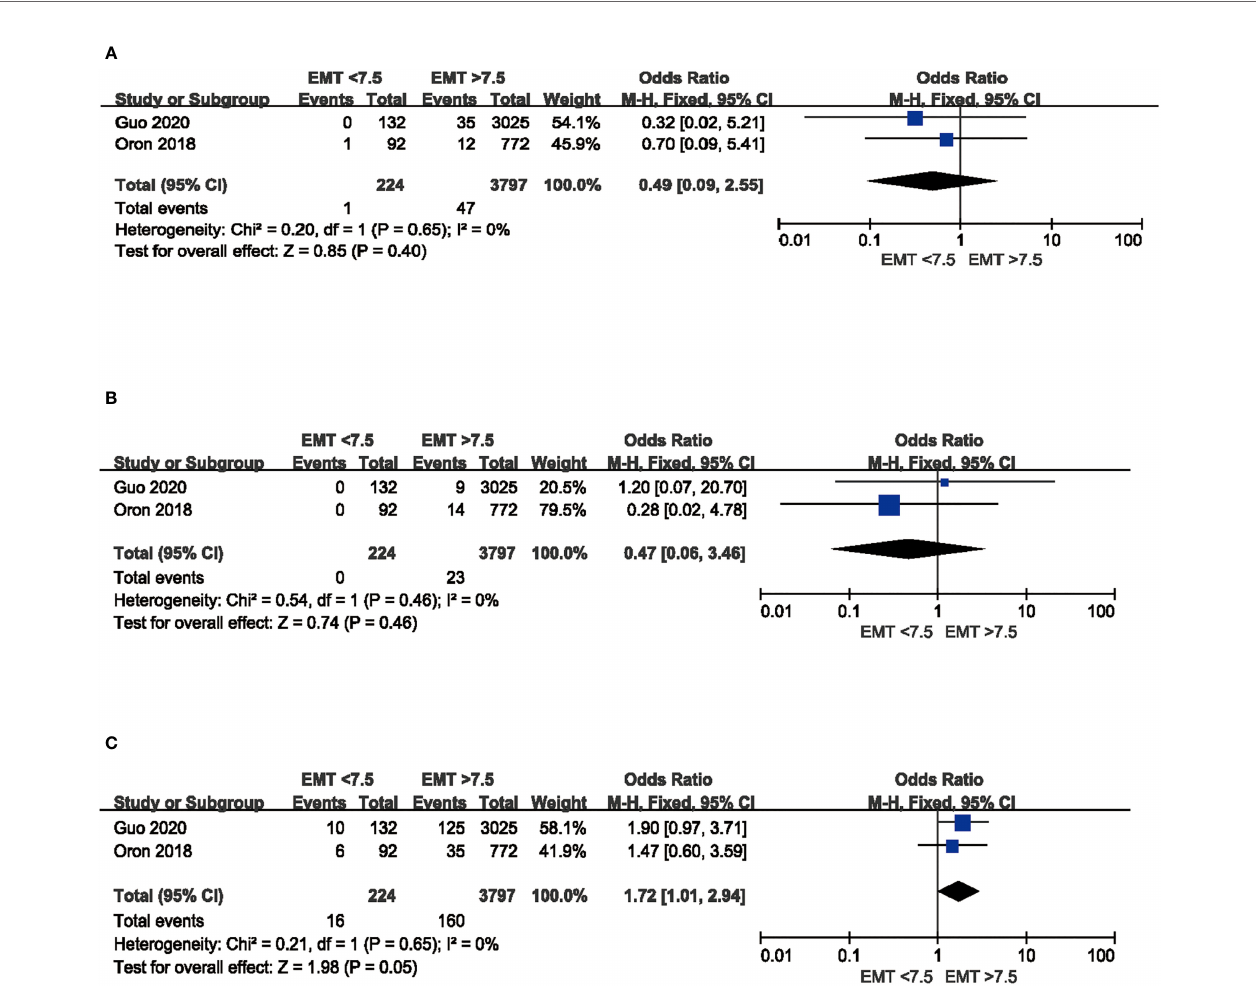
FIGURE 6 | Comparison of maternal outcomes between EMT <7.5 mm and EMT >7.5 mm in fresh cycles. (A) Comparison of PP between thin endometrium group and non-thin endometrium group. (B) Comparison of PA between thin endometrium group and non-thin endometrium group. (C) Comparison of HDP between thin endometrium group and non-thin endometrium group. PP, Placenta previa; PA, Placenta abruption; HDP, hypertensive disorders of